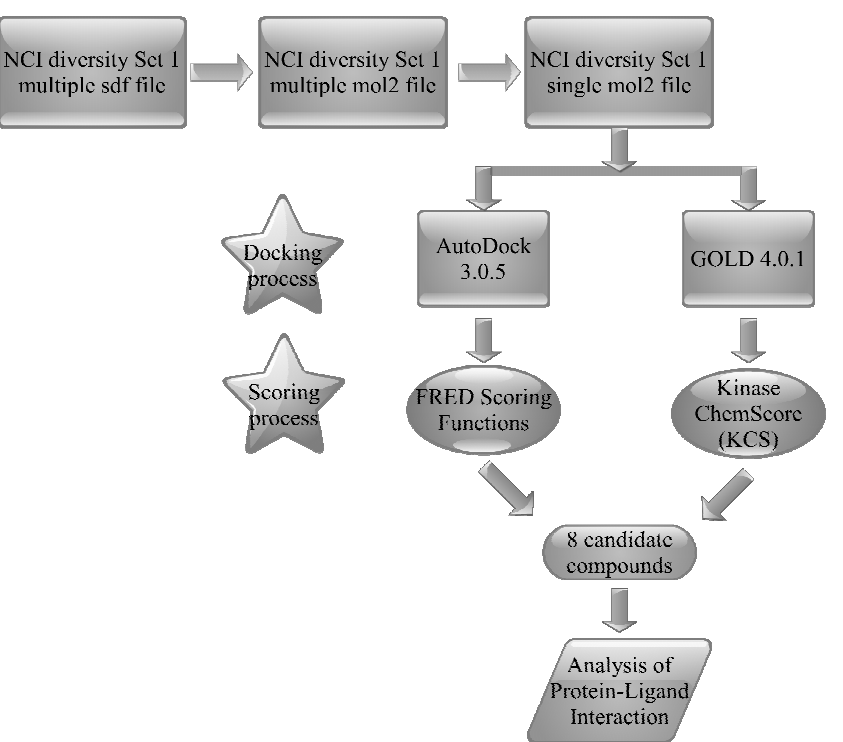
Figure 3. Schematic diagram of the molecular docking-based virtual screening